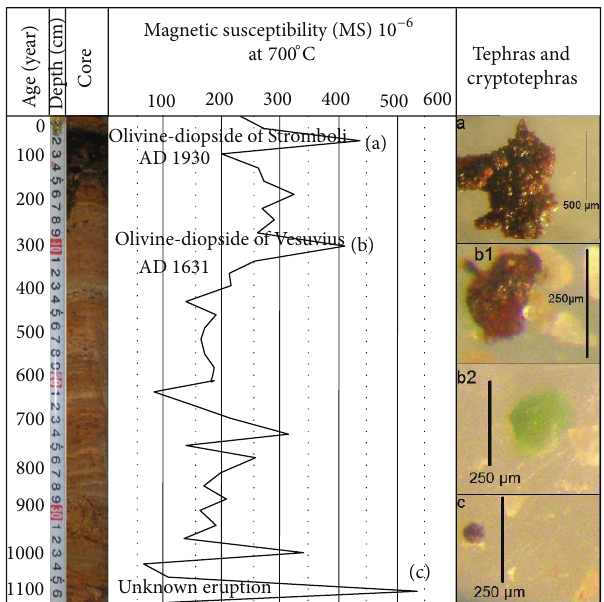
Figure 6: Magnetic susceptibility at 700 ∘ C along the core from sebkha Mhabeul: highlighting the signal of tephras layers.